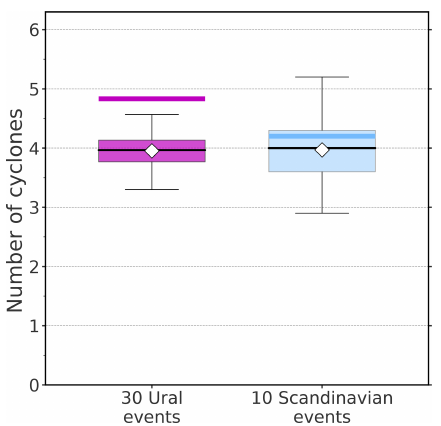
Figure 14. Cyclone climatology presented as the average cyclone frequency observed in the chosen sector (C, yellow sector in Fig. 13a and b; 50–70 ◦ N, 60–10 ◦ W) northwest of the main heating region during a 5d window (lags − 1 to − 6d relative to trajectory initialization within the block) for 30 Ural (magenta) and 10 Scandi- navian (light blue) events, computed using Monte Carlo resampling of 30 or 10 arbitrary events within the analysis period with 500 rep- etitions, respectively. The black horizontal line denotes the median, mean is shown with diamonds, the box refers to the IQR and the whiskers denote the 1st–99th percentile range of the distribution. The magenta and light-blue horizontal lines at each boxplot denote the cyclone frequency for the 5d window averaged over the 30 or 10 chosen Ural and Scandinavian events,